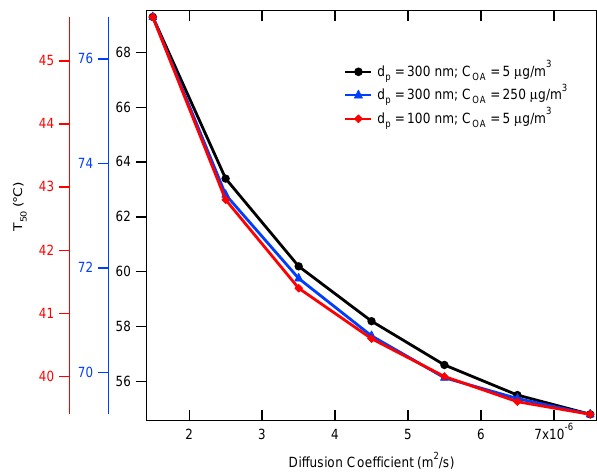
Fig. 10. Calculated dependence of T 50 on the diffusion coeffi- cient using the adsorbent denuder boundary condition (Case 1). The line colors correspond to the axis colors and were for (black) d p =300nm and C OA =5µg/m 3 , (blue) d p =300nm and C OA =250µg/m 3 and (red) d p =100nm and C OA =5µg/m 3 . In all cases, 1H vap =75kJ/mol, C sat =5µg/m 3 and t res =15s. The general form of the relationship between T 50 and D i is relatively insensi- tive to the specific conditions (e.g. 1H vap , d p , C OA ) , although the absolute range over which T 50 varies depends on these parameters.